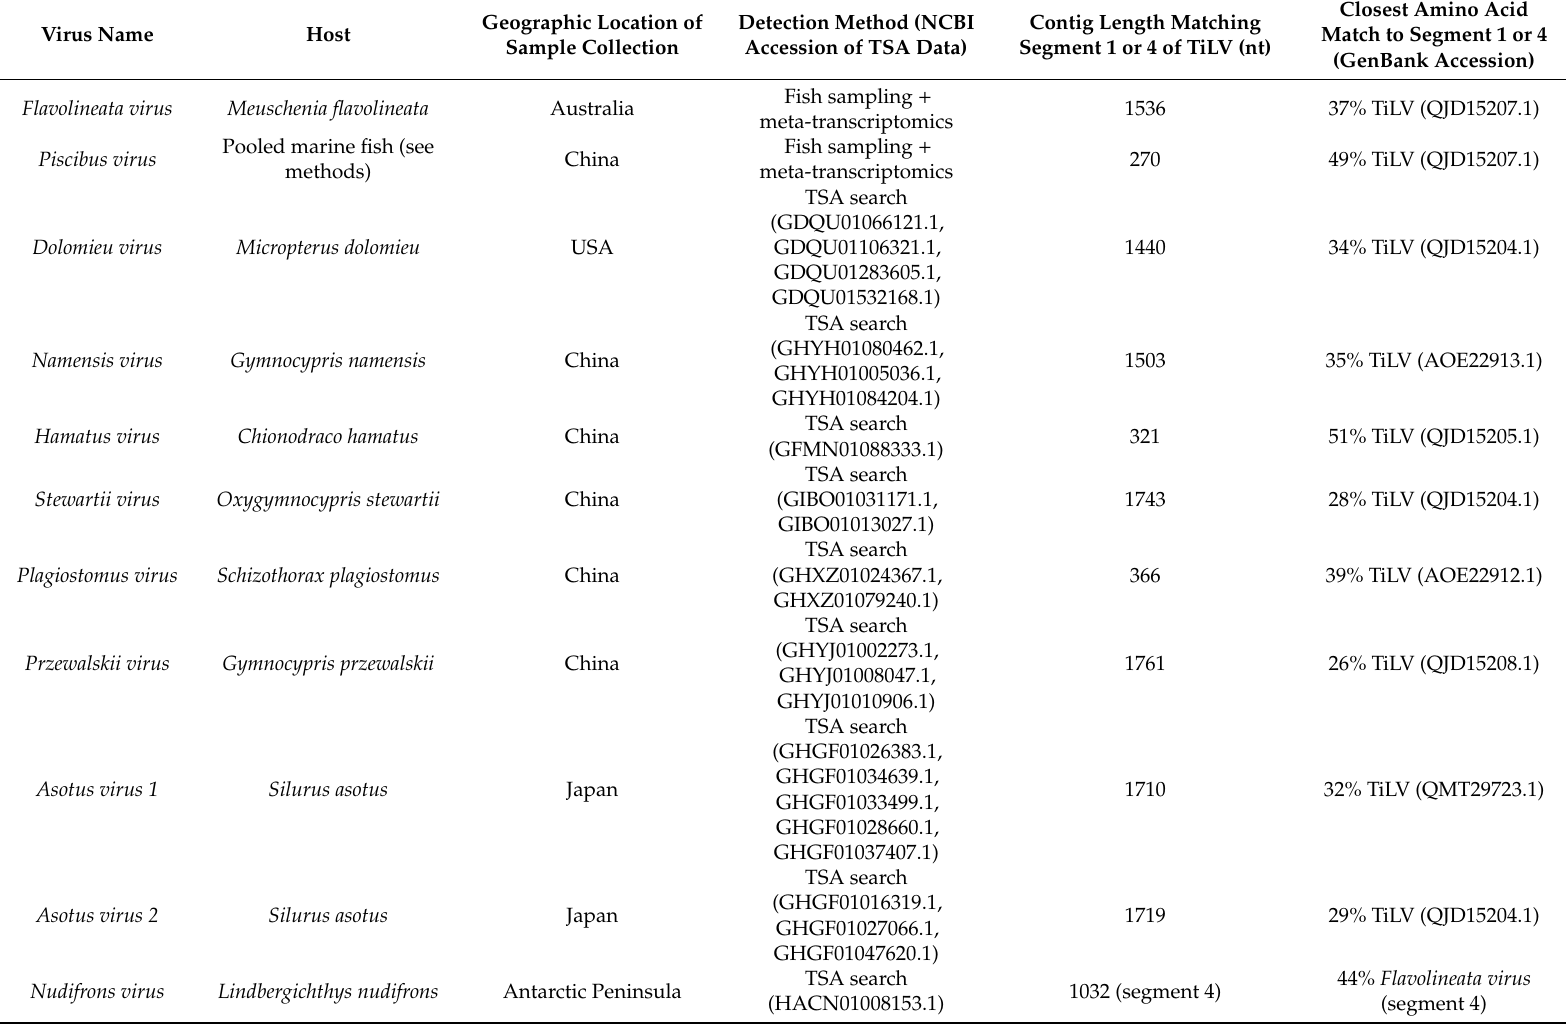
Table 1. Novel viruses identified in this